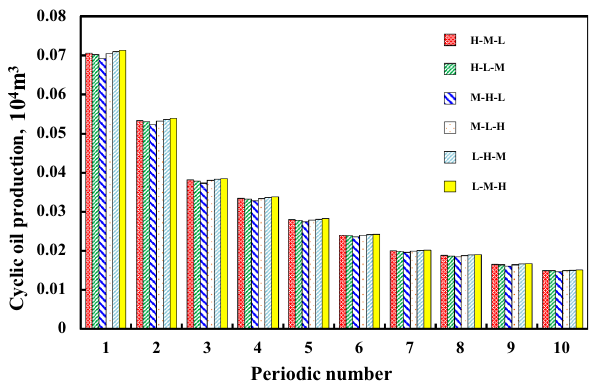
Fig. 5 The effect of permeability distribution pattern on the cyclic oil